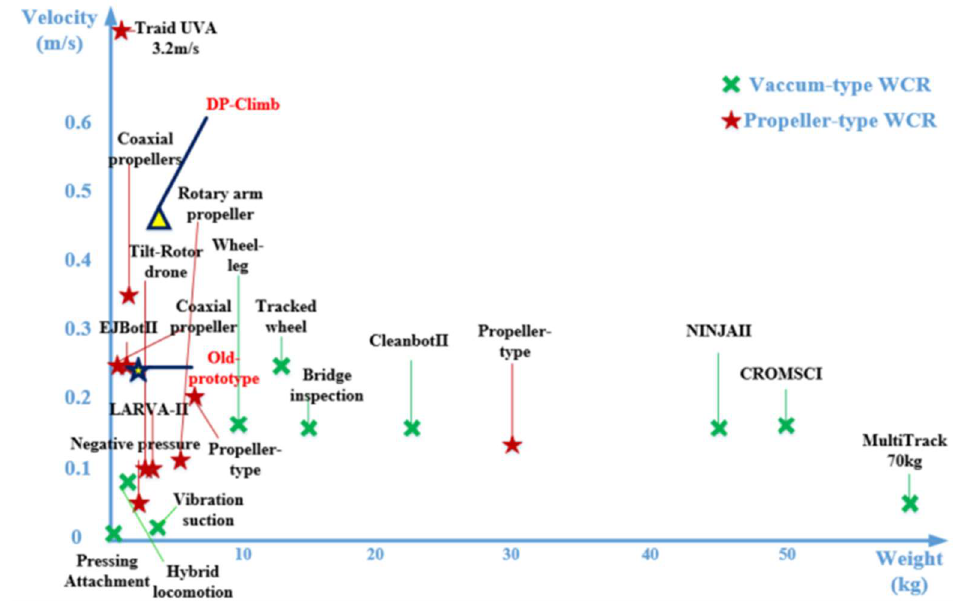
Figure 1. Property comparison of negative pressure WCRs.